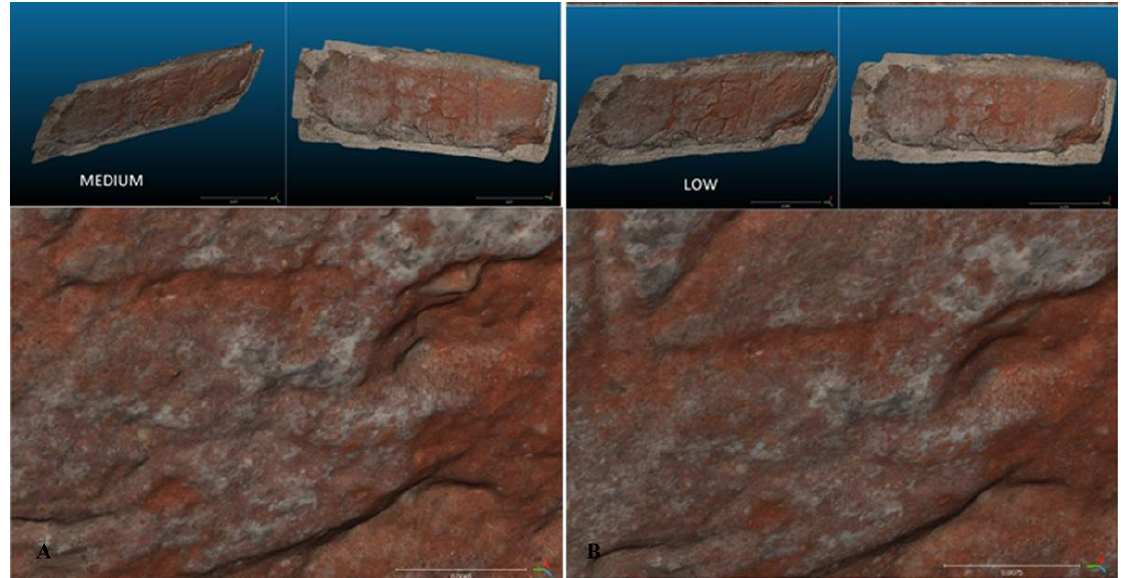
Figure 8. Mesh 3D models of the W-9-3 engraving generated basing on medium and low point